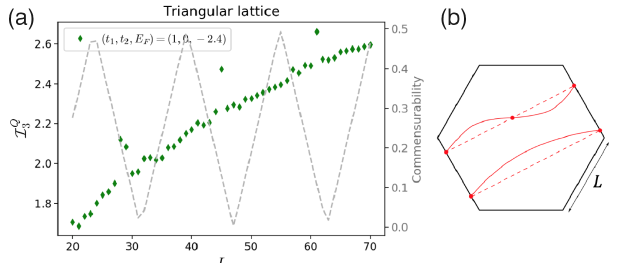
FIG. 18. Outliers due to the hard-wall boundary condition. Panel (a) shows an example of how I Q 3 (green diamond) increases with L for the densest sampling ( Δ L ¼ 1 ). There is a smooth background, comparable to our scaling prediction, together with outliers appearing periodically. The outliers are related to electrons on the Fermi surface bouncing back and forth between the open boundary, as shown in (b), forming standing wave when the condition in Eq. (E1) is satisfied [see the dashed line in (a), and discussion in the text]. We conjecture that these nonlocal states enhance the entanglement and cause the jumps seen in